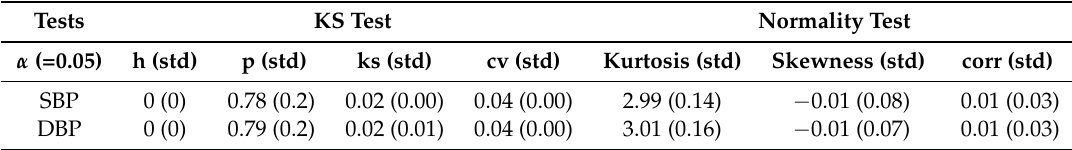
Table 8. Statistical results such as skewness, kurtosis, Kolmogorov-Smirnov (KS), Spearman’s correlation between the SBP and DBP estimations, where the results are the average values for our test